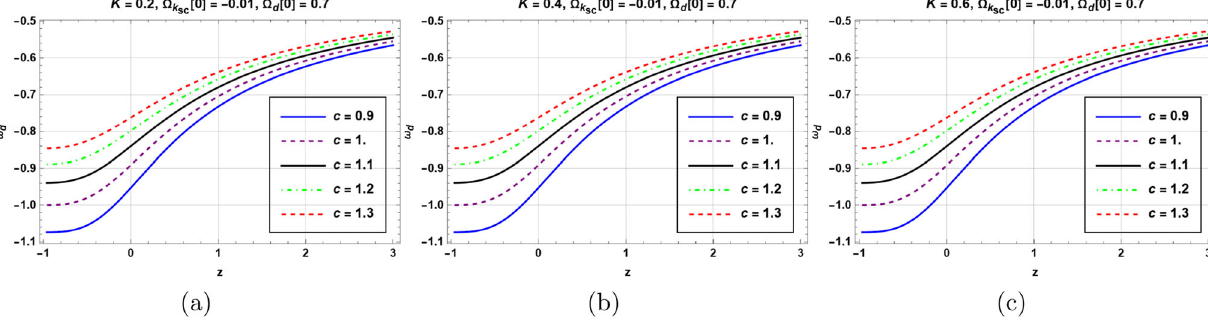
Fig. 4 The variation in the EoS parameter w d with redshift z for the open universe, in units when M 2 p = 1 , H 0 = 67 . 9. In order to be consistent with data, we now imposed (cid:2) d ( x = − ln ( 1 + z ) = 0 ) = (cid:2) d [ 0 ] = 0 .